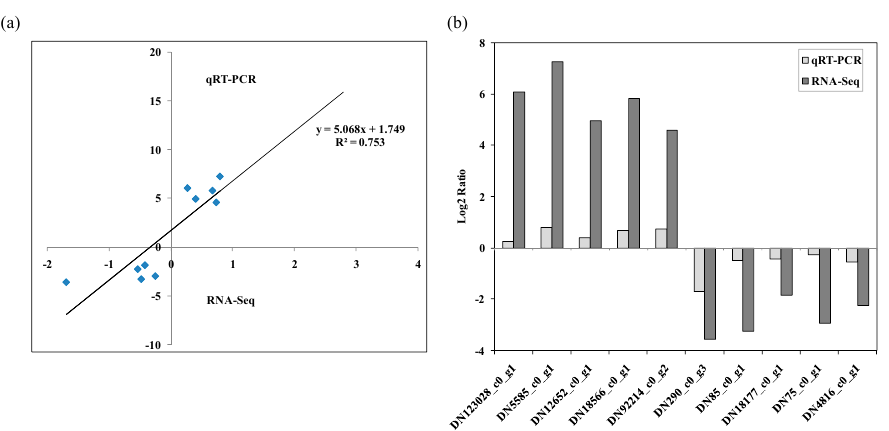
Figure 6. Validation of DEGs in leaves of ryegrass exposed to Cd stress. ( a ) the correlation between the RNA-Seq and qRT-PCR data from 10 selected DEGs in leaves of ryegrass exposed to Cd stress, ( b ) comparison of the relative expression of 10 selected DEGs in ryegrass leaves exposed to Cd stress by RNA-Seq and qRT-PCR.